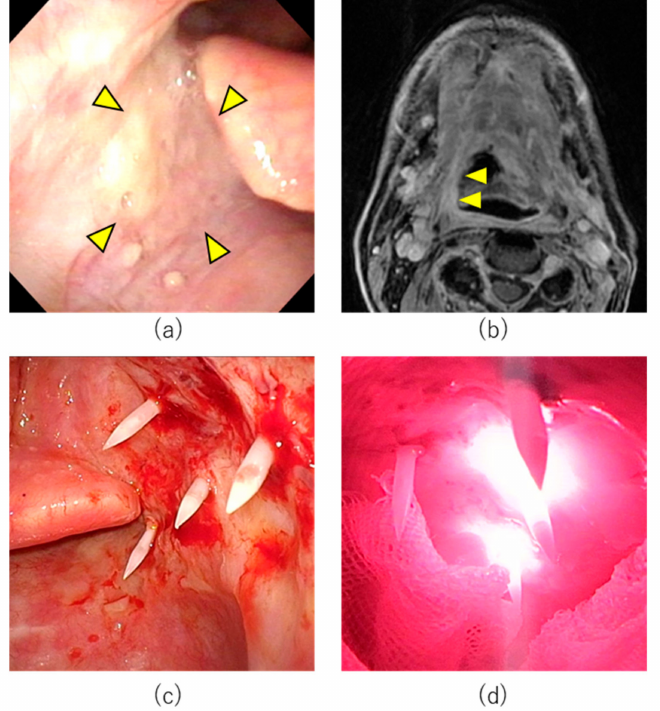
Figure 4. Treatment course of Case 2. ( a ) Pretreatment endoscopic findings with white light. Right base of tongue tumor (arrowheads). ( b ) Axial section of Gd-enhanced MRI T1 weighted image. The tumor was enhanced (arrowheads). ( c ) Needle catheters were punctured percutaneously into the pharynx in HN-PIT. ( d ) Near-infrared laser illuminated the